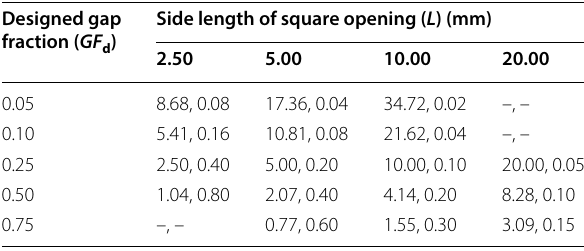
Table 1 Designed gap fraction ( GF of square opening ( L ) of the 17 model